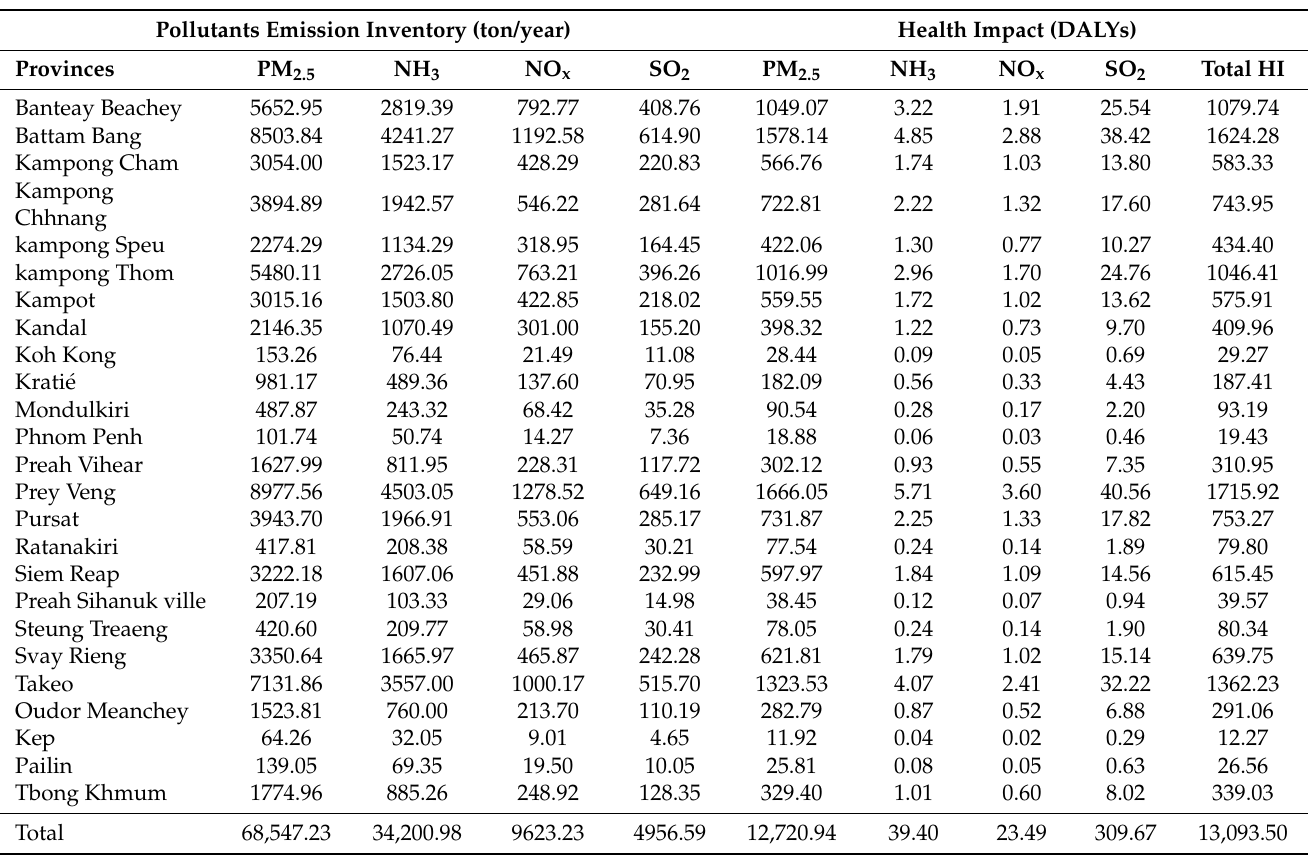
Table A2. Provincial level Emission Inventory and Health Impact from rice straw production in